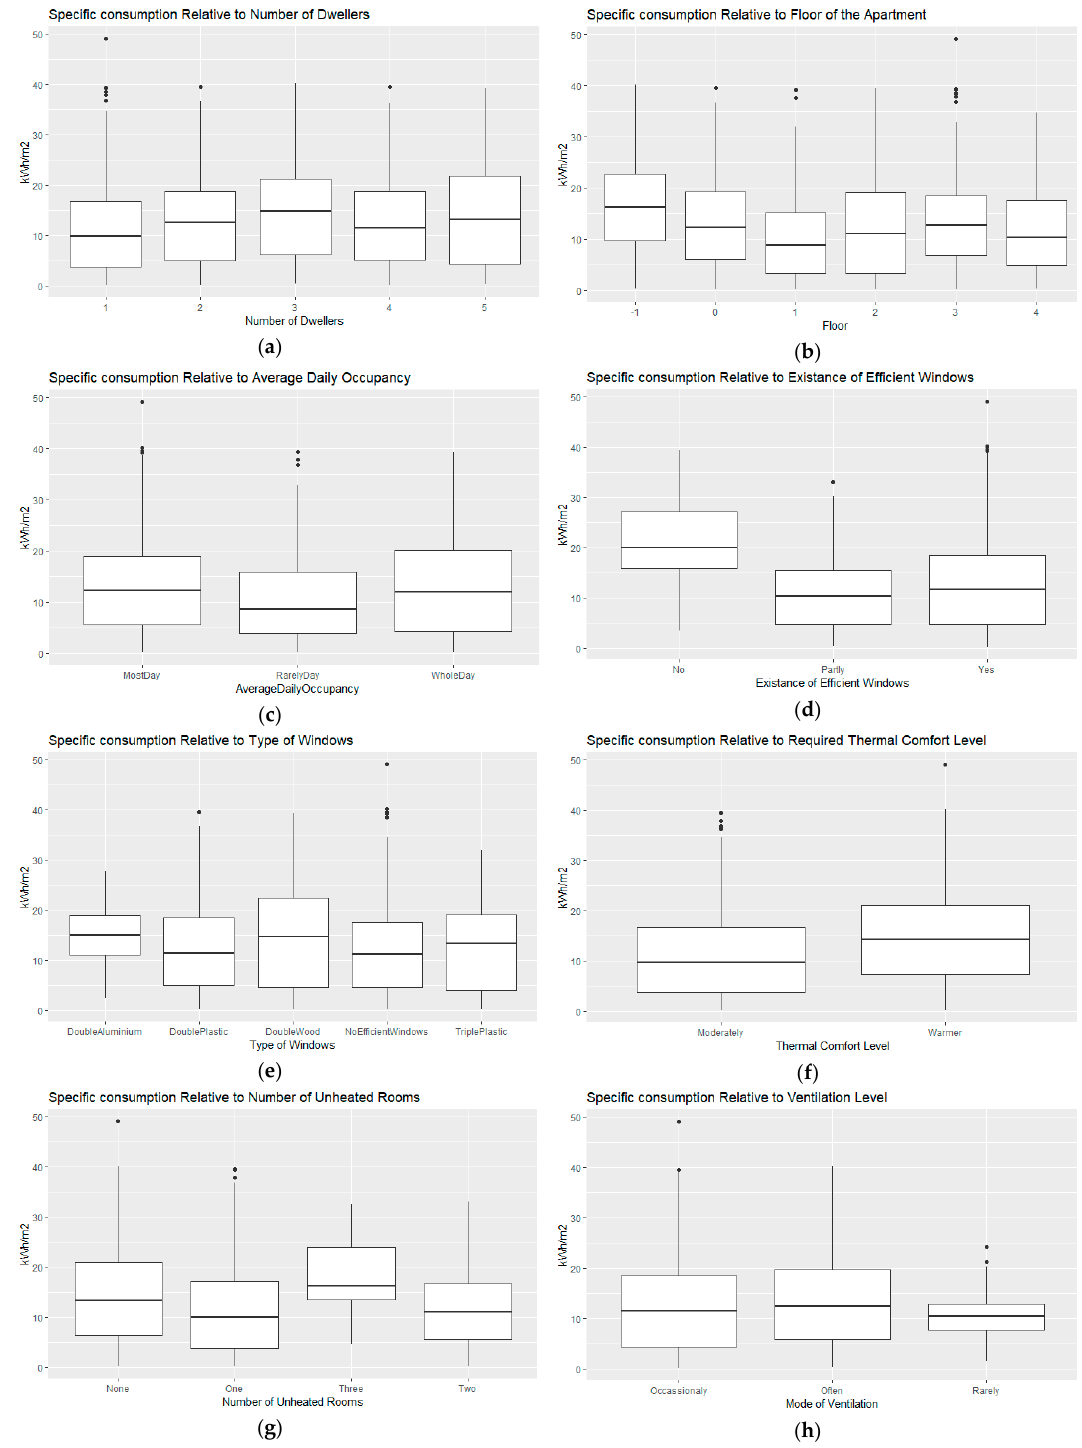
Figure 8. Visualisation of box and whisker plots for each analysed qualitative predictor, representing quartiles, the median, minimum and maximum of data and outliers: ( a ) Specific consumption relative to the number of dwellers; ( b ) Specific consumption relative to the floor on which apartment is located. ( c ) Specific consumption relative to daily occupancy. ( d ) Specific consumption relative to the existence of energy efficient windows. ( e ) Specific consumption relative to the type of windows. ( f ) Specific consumption relative to the desired level of thermal comfort. ( g ) Specific consumption relative to the number of unheated rooms. ( h ) Specific consumption relative to the ventilation